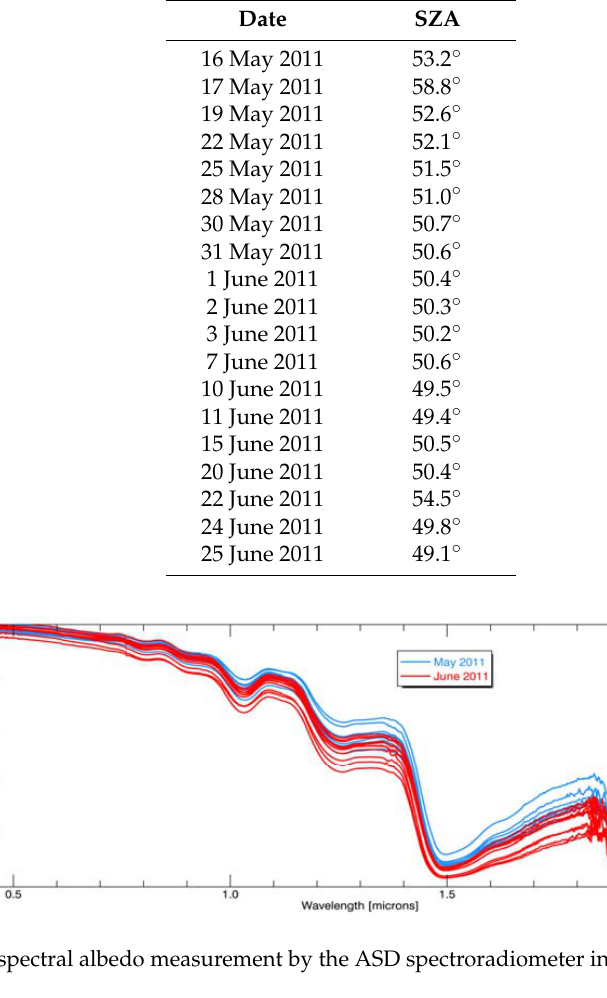
Table 1. Date and solar zenith angles of the in situ measurements.